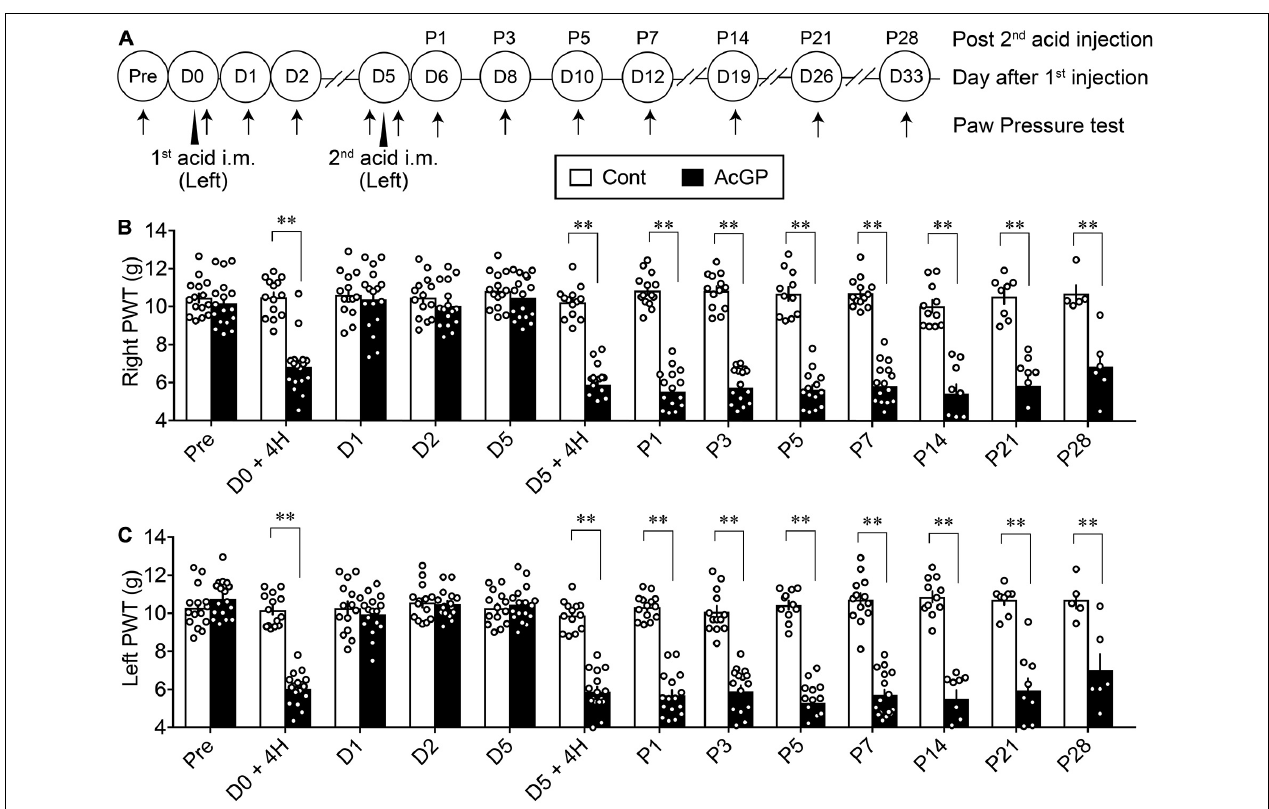
FIGURE 1 | Bilateral mechanical allodynia by intramuscular injections of acid saline. (A) Twenty microliters of acid saline (pH 4.0) or control saline (pH 7.2) was injected into the “Left” gastrocnemius muscle twice 5 days apart, as indicated by arrowheads. Mechanical paw pressure tests on both sides were performed at the indicated time points (arrows). The day for the first acid saline injection is indicated as day 0/D0, and the next day after the second acid saline injection is indicated as P1. (B,C) Mechanical allodynia on the contralateral (right, B ) and ipsilateral side (left, C ) following the acid saline injections into the left gastrocnemius muscle at D0 and D5. The transient and long-lasting allodynia following first and second acid saline, respectively, were evaluated by the paw pressure test on both sides. ∗∗ p < 0.01, compared with vehicle-treated control (Cont) mice at each time point, in two-way repeated measures ANOVA followed by Bonferroni’s multiple comparisons test (Cont n = 5–15, AcGP n = 6–17). The dots in the column represent number of animals. AcGP, acid saline-induced FM-like generalized pain; PWT, paw withdrawal